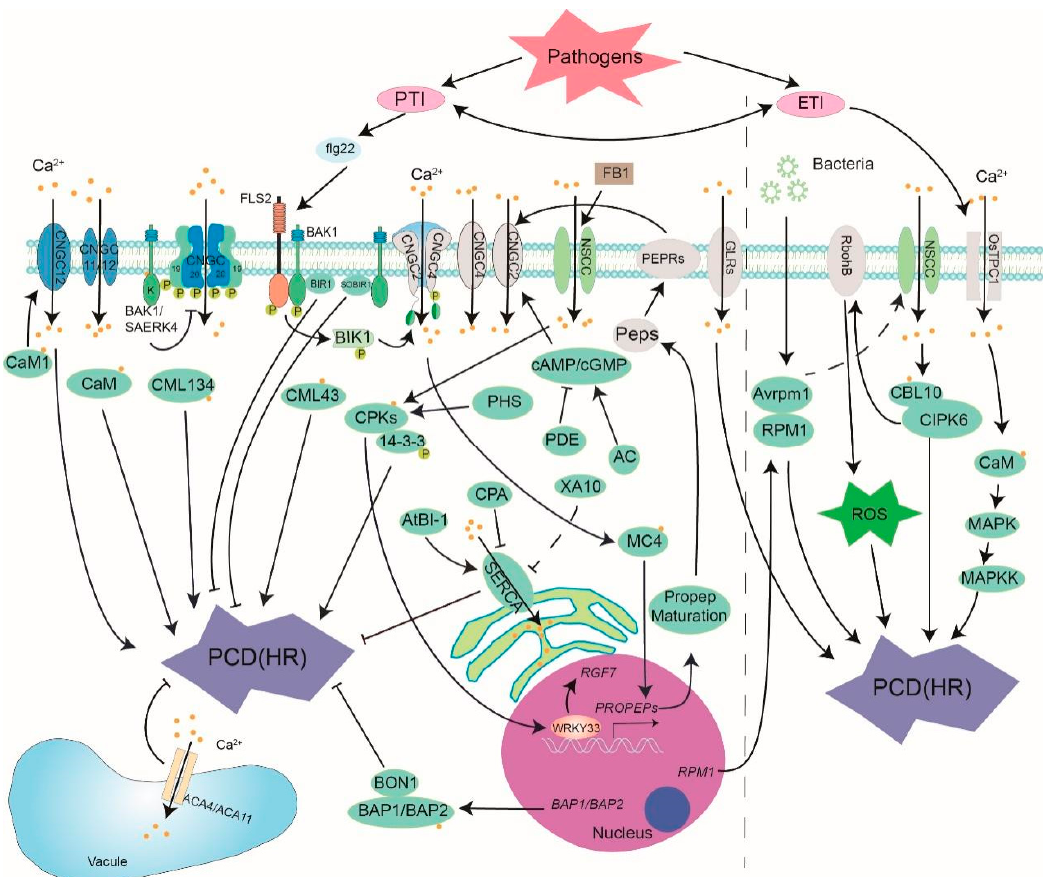
Figure 1. The role of calcium signal in biotic stress-induced PCD. Ca 2+ channel, sensor and relative gene and protein are presented. PTI: pattern-triggered immunity; ETI: effector-triggered immunity; flg22: a 22 amino acid PAMP derived from bacterial flagellin; FB1: Fumonisins B1; FLS2: Flagellin-sensitive 2; CNGCs: Cyclic nucleotide gated channel; BAK1: brassinosteroid insensitive 1-associated receptor kinase 1; SERK4: Somatic embryogenesis receptor kinase 4; BIK1: botrytis- induced kinase 1; BIR1: BAK1-interacting receptor-like kinase 1; SOBIR1: suppressor of BIR1-1; Peps: plant elicitor peptide; PEPRs: extracellular Pep receptors; CaM: calmodulin; CML: CaM-like protein; CDPK(CPK): Ca 2+ -dependent protein kinase; CBL: calcineurin B-like protein; CIPK: CBL-interacting protein kinase; cAMP: 3’-5’-cyclic adenosine monophosphate; cGMP: cyclic guanosine monophosphate; AC: adenylate cyclase; PDE: phosphodiesterase; PHS: phytosphingosine; MC4: metacaspase 4; 14-3-3: 14-3-3 proteins; SERCA: sarco-endoplasmic reticulum Ca 2+ -ATPase; ACA: autoinhibited Ca 2+ - ATPase; RPM1: resistance to Pseudomonas syringae pv. Maculicola 1; AvrRpm1: Pseudomonas syringae type III effector; MAPK: Mitogen activated protein kinase (based on